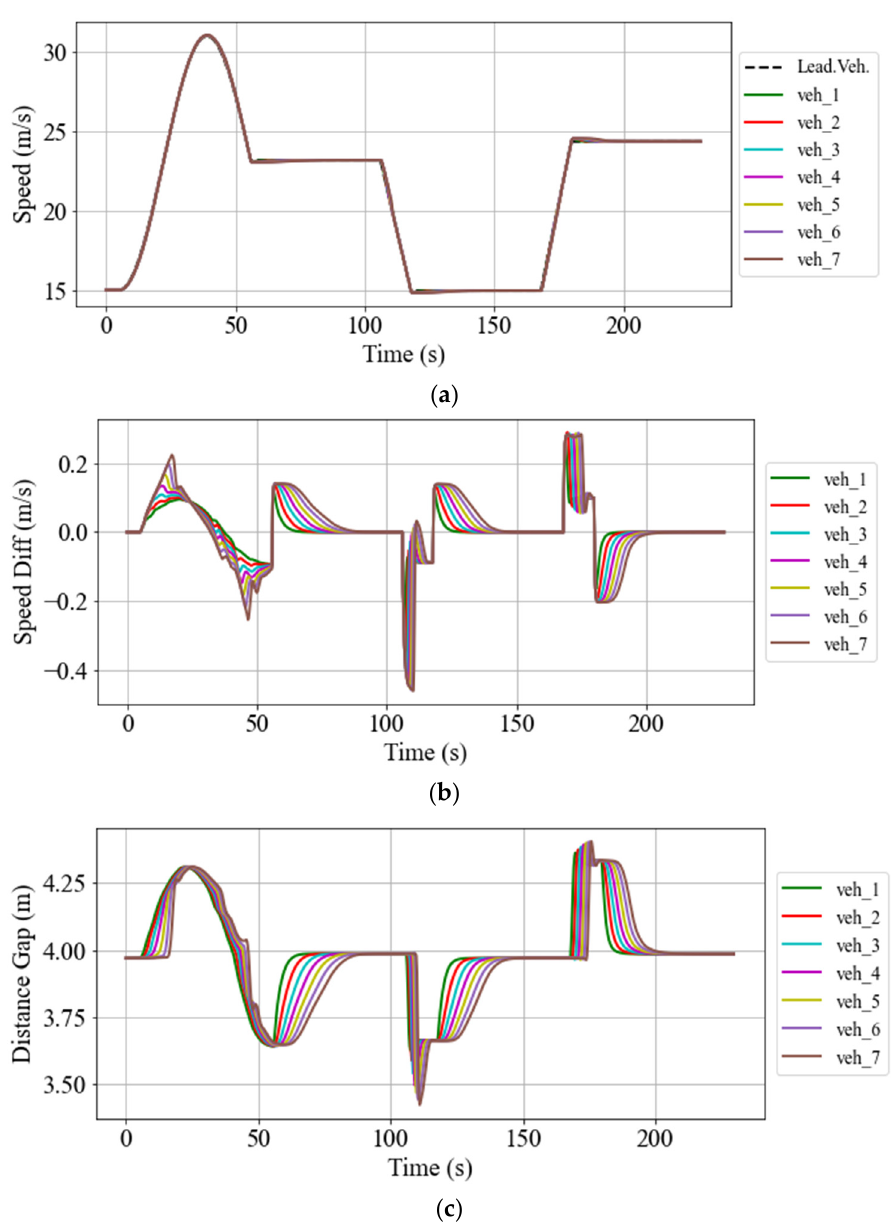
Figure 5. Variations in speed ( a ), speed difference ( b ), and distance gap ( c ) of participant vehicles in the platoon system with respect to speed trajectory followed by the leading vehicle.